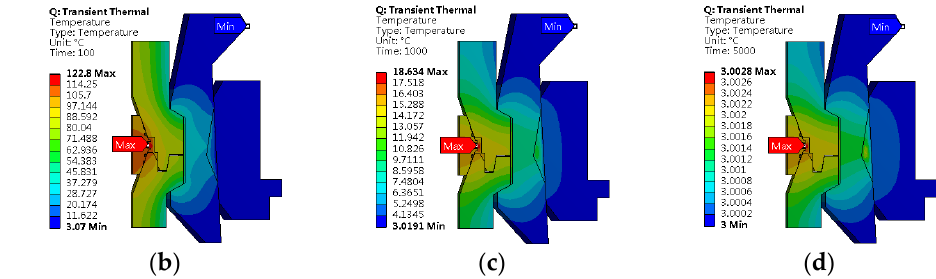
Figure 4. Transient temperature field of subsea collet connector under the working condition of instantaneous temperature drop. ( a ) 10 s; ( b ) 100 s; ( c ) 1000 s; ( d ) 5000 s. Table 4. The time required for each component to drop to the seawater temperature under the work- ing condition of instantaneous temperature drop.